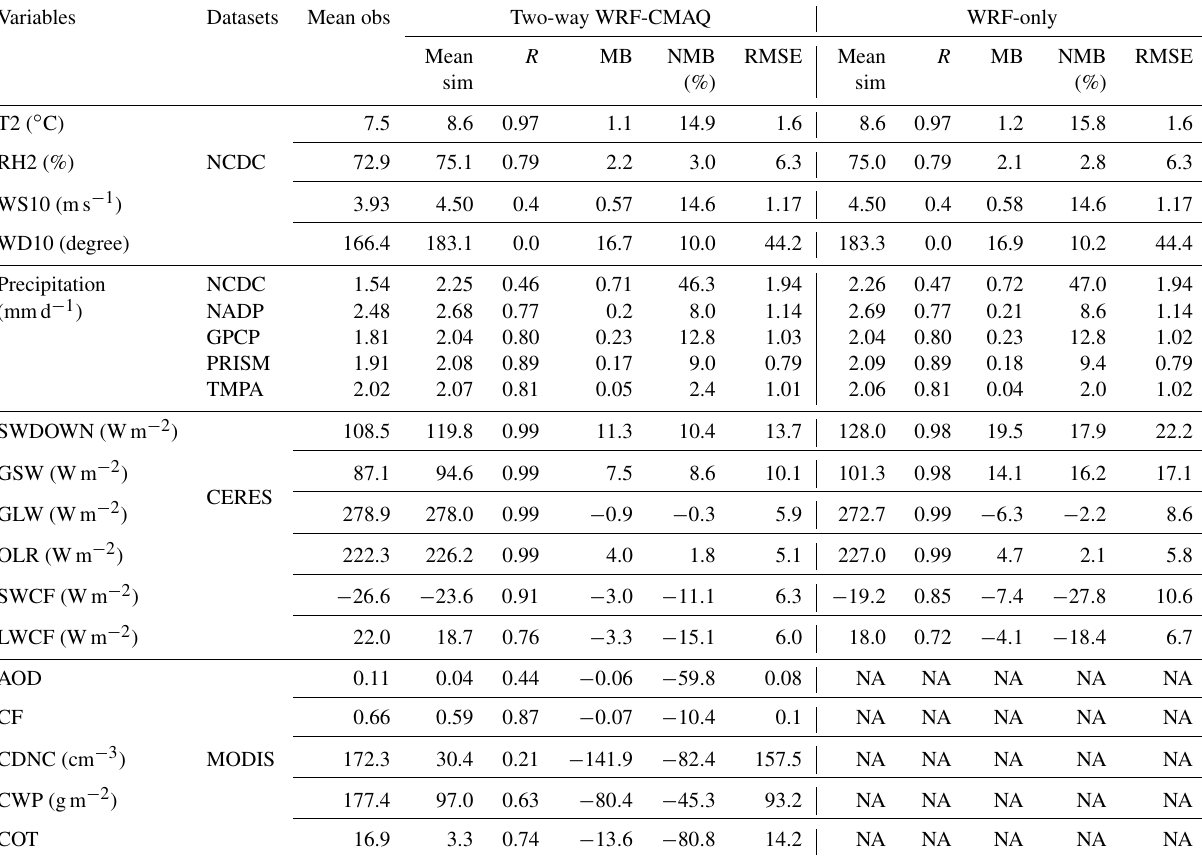
Table 1. The 5-year average performance statistics for meteorological variables between two-way WRF-CMAQ and WRF-only simulations in winter